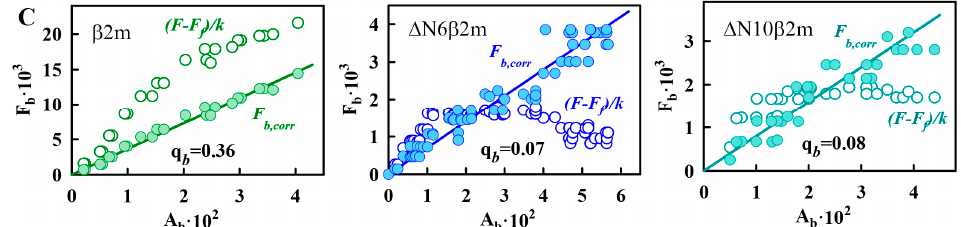
Figure 4. Investigation of β 2M amyloid fibrils interaction with ThT. ( A ) Dependences of the fluorescence intensity of ThT bound to different variants of β 2M amyloid fibrils corrected for the primary inner filter effect on the initial dye concentration. ( B ) Dependences of the absorbance of ThT bound to different variants of β 2M amyloid fibrils on its concentration. ( C ) Dependences of the fluorescence intensity of the ThT bound to different variants of β 2M amyloid fibrils, without (open circles) and with corrections (filled circles) for the primary inner filter effect on absorbance of bound dye. The panels ( A – C ) show the experimental data (circles), best-fit curves and lines (solid lines) and the determined values of the binding constants ( K b ) and the number of binding sites ( n ), the molar extinction coefficients ε b and florescence quantum yields q b of the ThT bound to β 2m (left panels), ∆ N6 β 2m (middle panels), and ∆ N10 β 2m (right panels) amyloid fibrils.